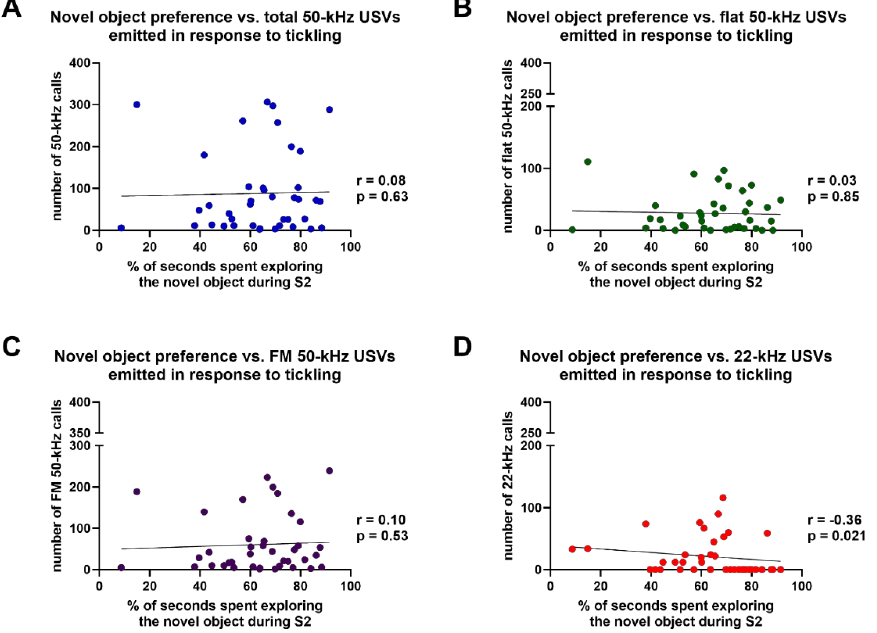
Figure 5. Results of Spearman’s correlation test of the percentages of time spent exploring the